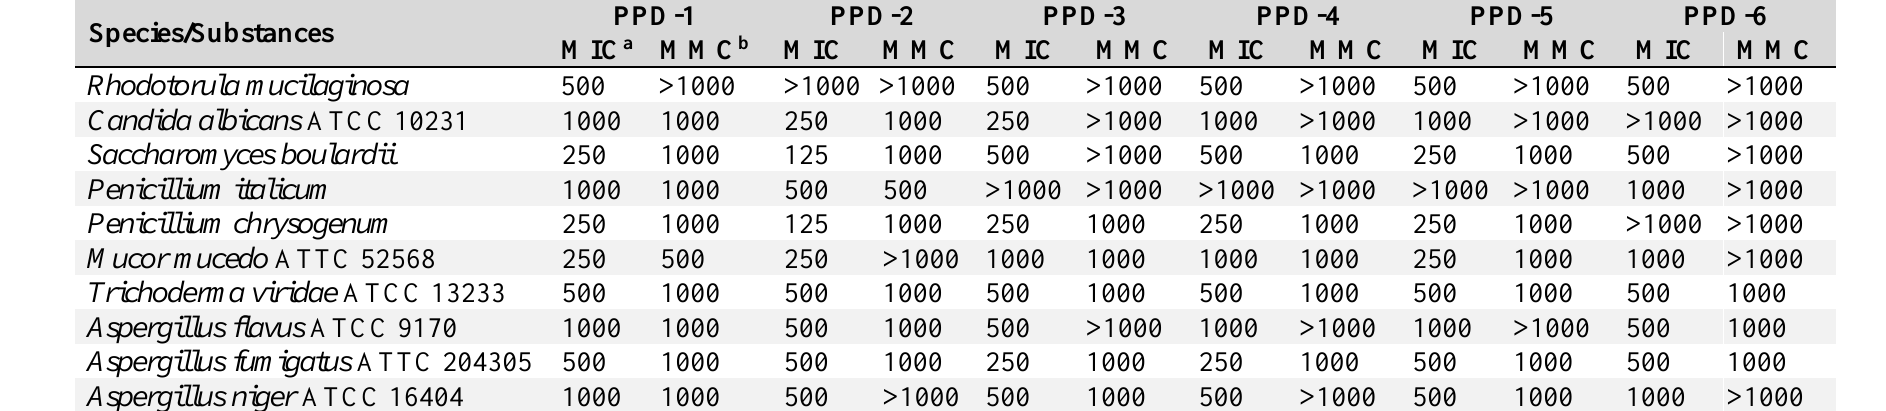
Table 3. Antifungal activity of tested